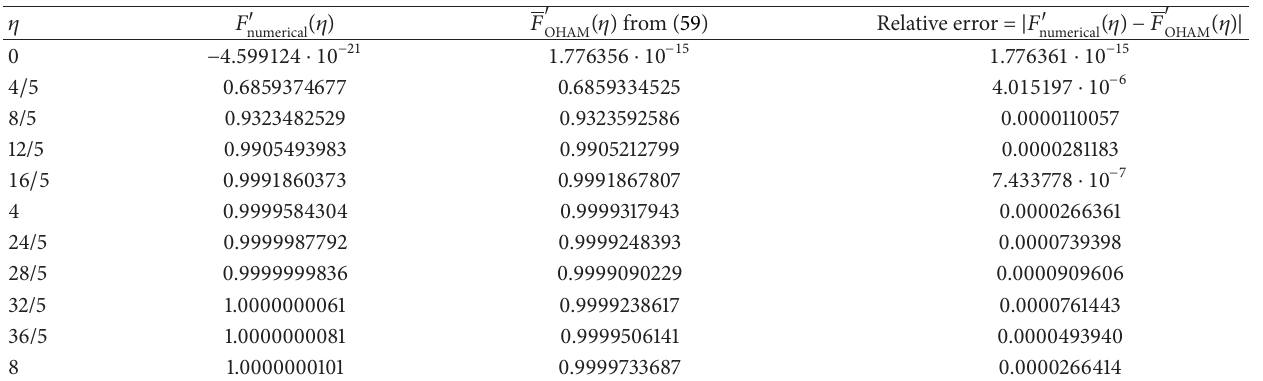
󸀠 (𝜂) obtained from (59) and numerical results for 𝛽 = 1 .